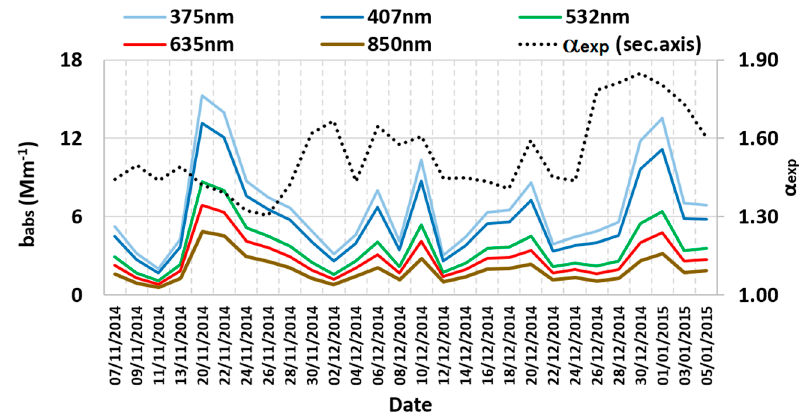
Figure 2. 5- λ aerosol absorption coefficient (b abs ) and the Ångström absorption coefficient ( α exp) determined on the Propata dataset. Date referring to the beginning of the sampling is reported on the x-axis.